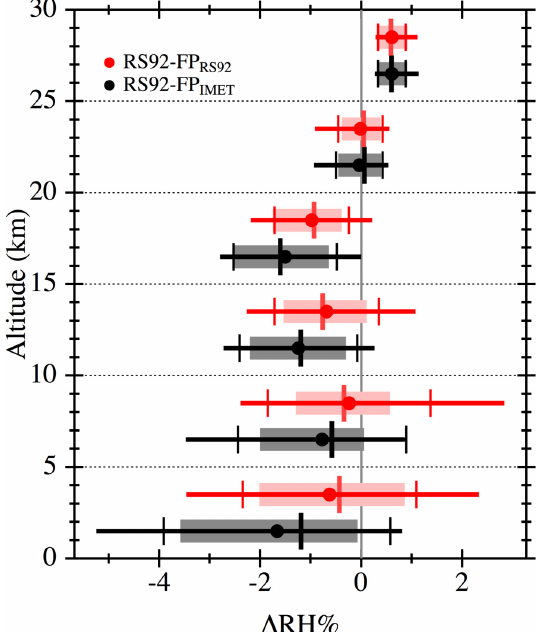
Fig. 16. Statistics of 1 RH for RS92-FP RS92 (red) and RS92- FP IMET (black) in 5-km altitude bins. Each of the symbols rep- resents the same statistics of differences described for Fig. 5. Sta- tistically significant biases are revealed for both RS92-FP RS92 and RS92-FP IMET in the 15–20 and 25–30km bins. These is also a significant RS92-FP IMET bias at 10–15km, and the median RS92- FP IMET RH difference for the 0–5km bin is statistically different from